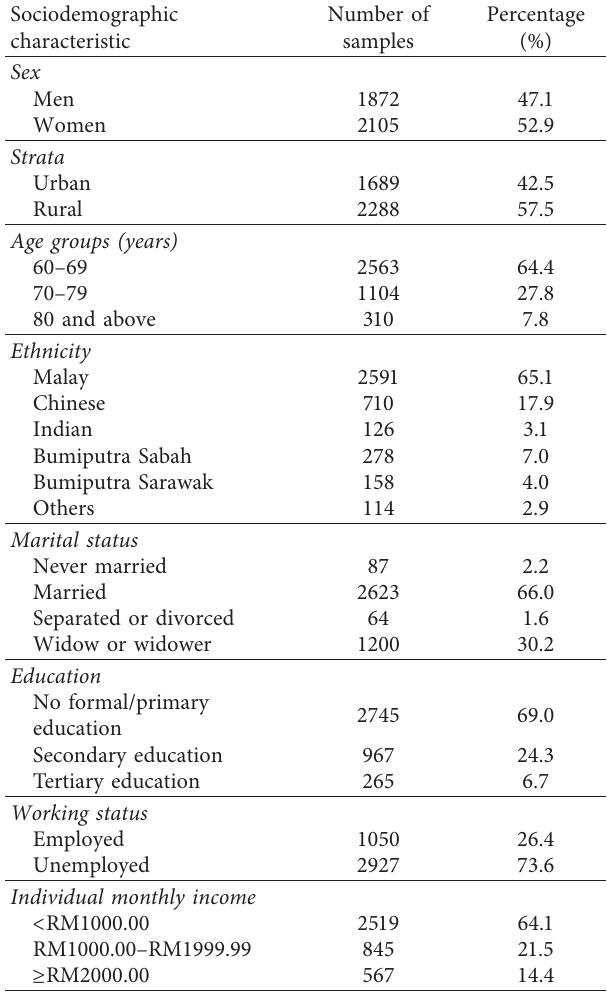
Table 1: Sociodemographic characteristics of the respondents ( N �